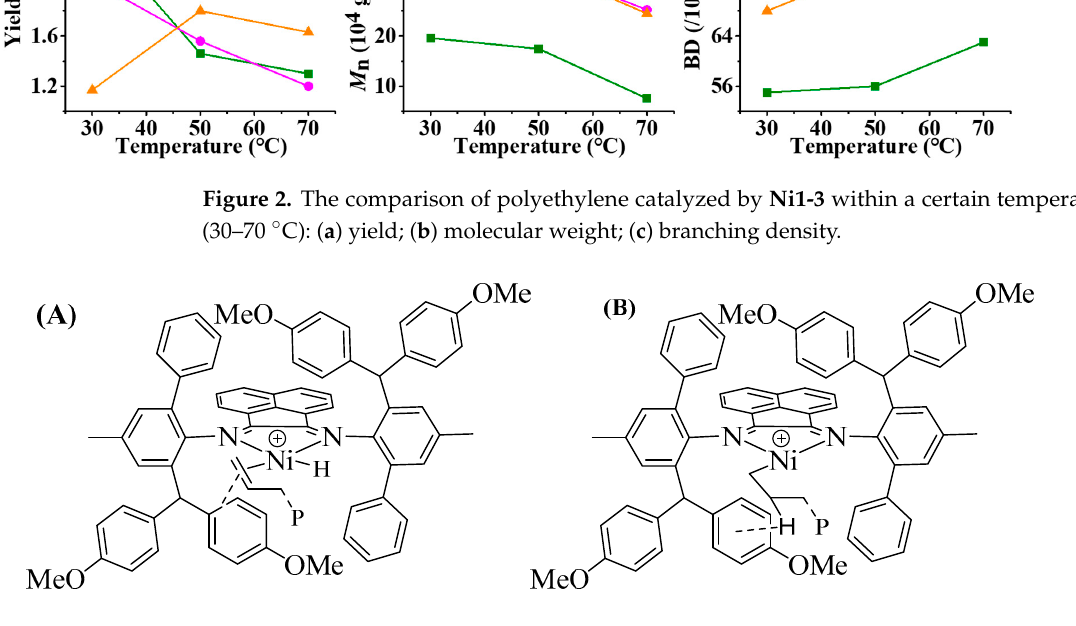
Figure 3. The weak neighbor–group interactions promote the chain transfer ( A ) and suppress β -H elimination ( B ) in ethylene polymerization.